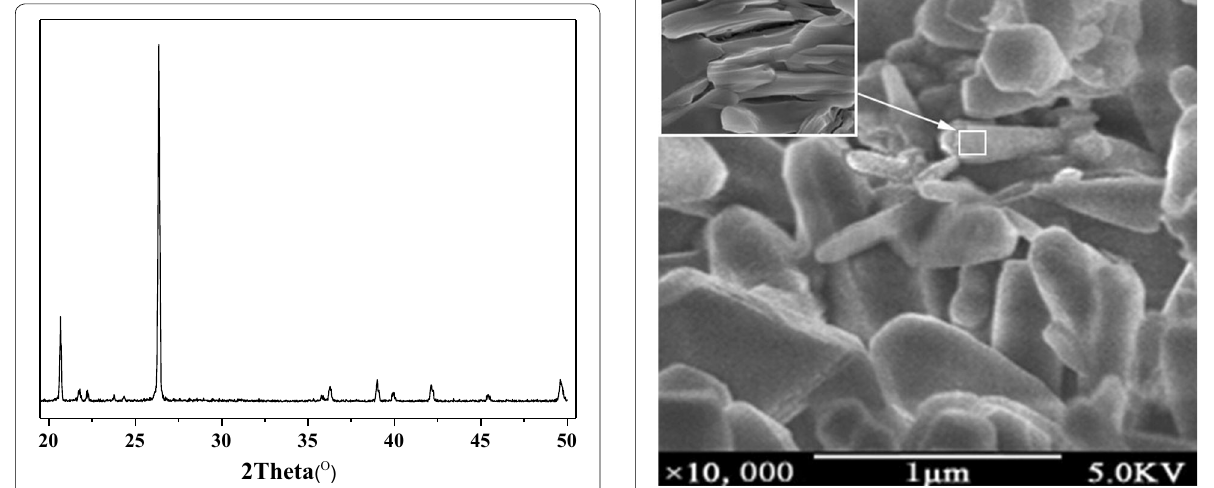
Fig. 1 XRD pattern of the VAlPO 4 catalyst Fig. 2 SEM pictures of the VAlPO 4